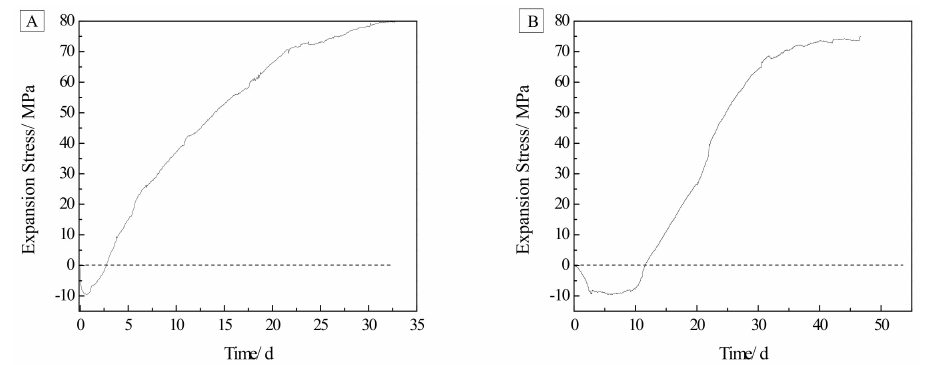
Figure 6. Expansion stress curve of compacted bodies: ( A ) compacted body cured in 1 mol / L NaOH solution at 60 ◦ C; ( B ) compacted body cured in 1 mol / L TMAH solution at 60 ◦